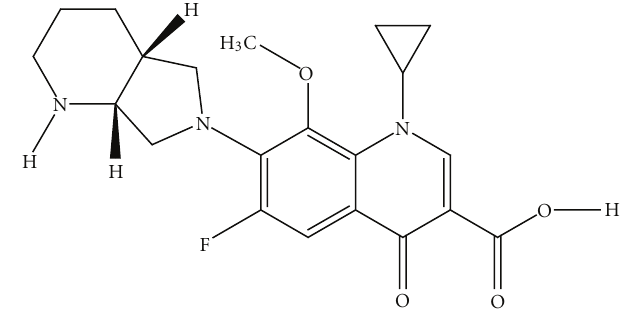
Figure 1: Chemical structure of